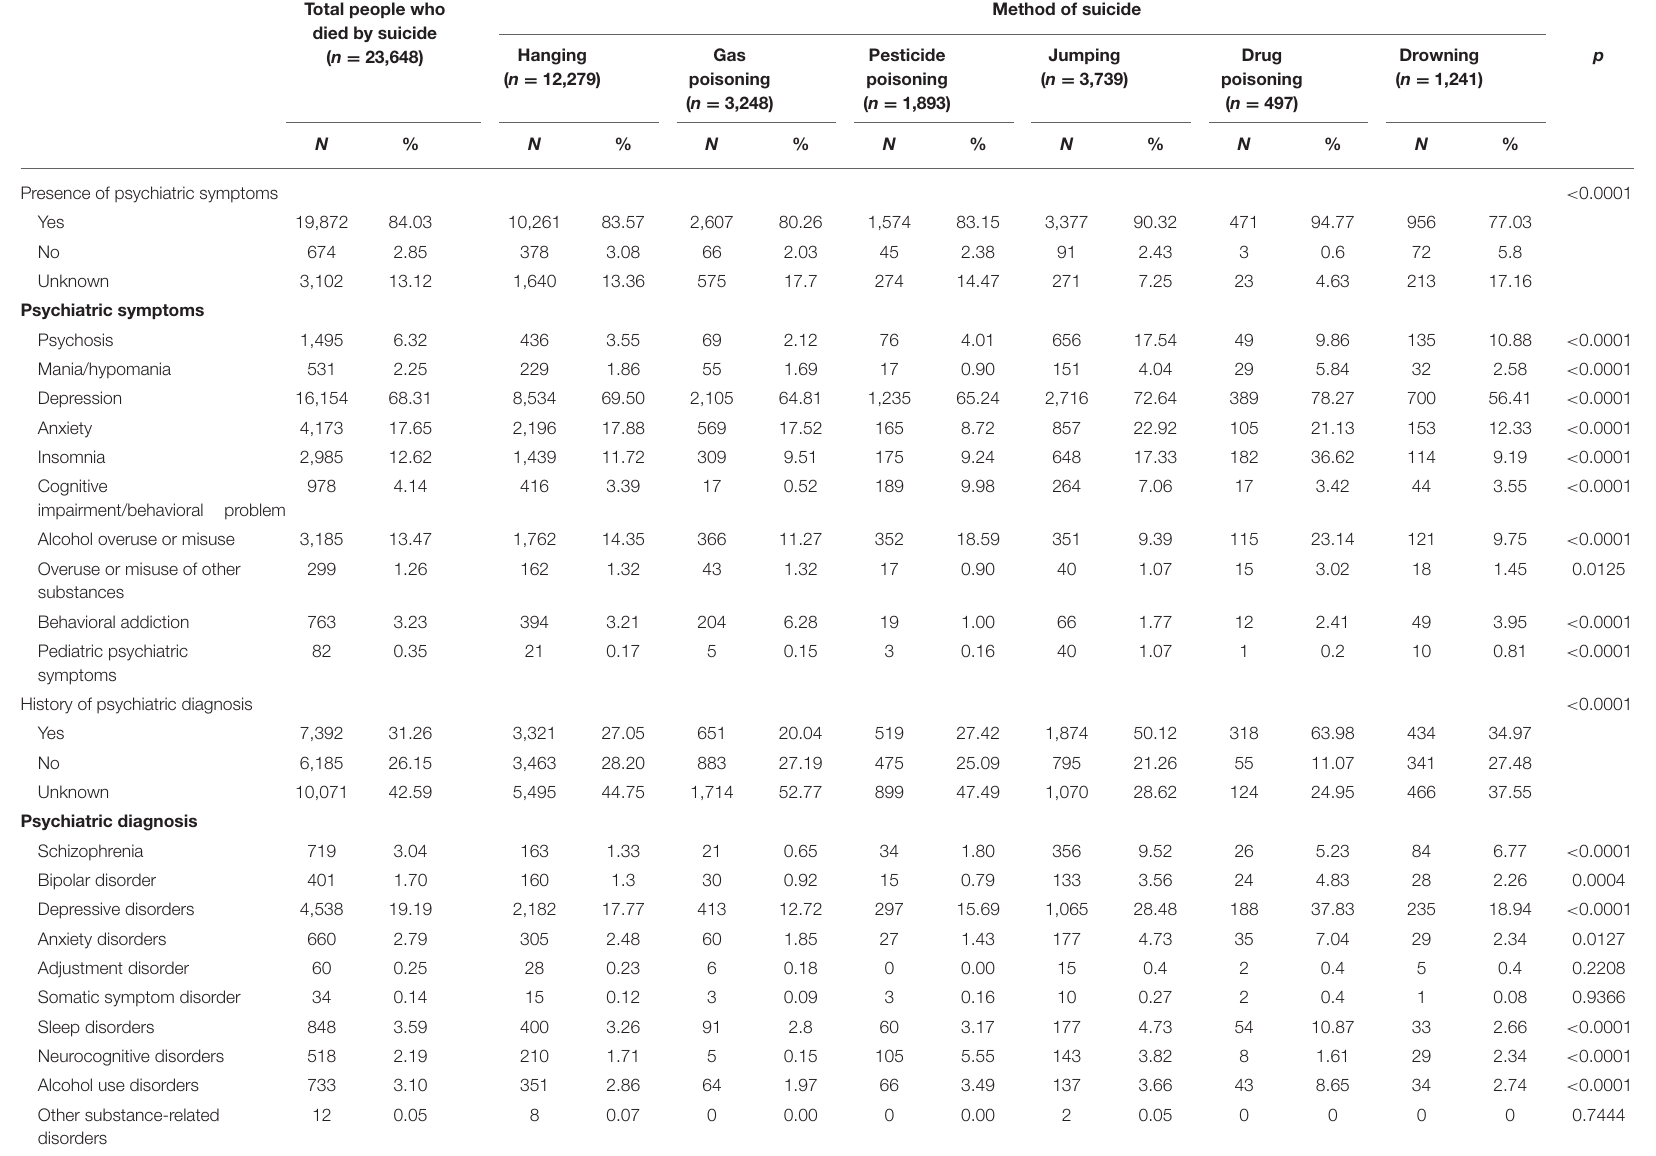
TABLE 2 | Psychiatric characteristics of people who died by